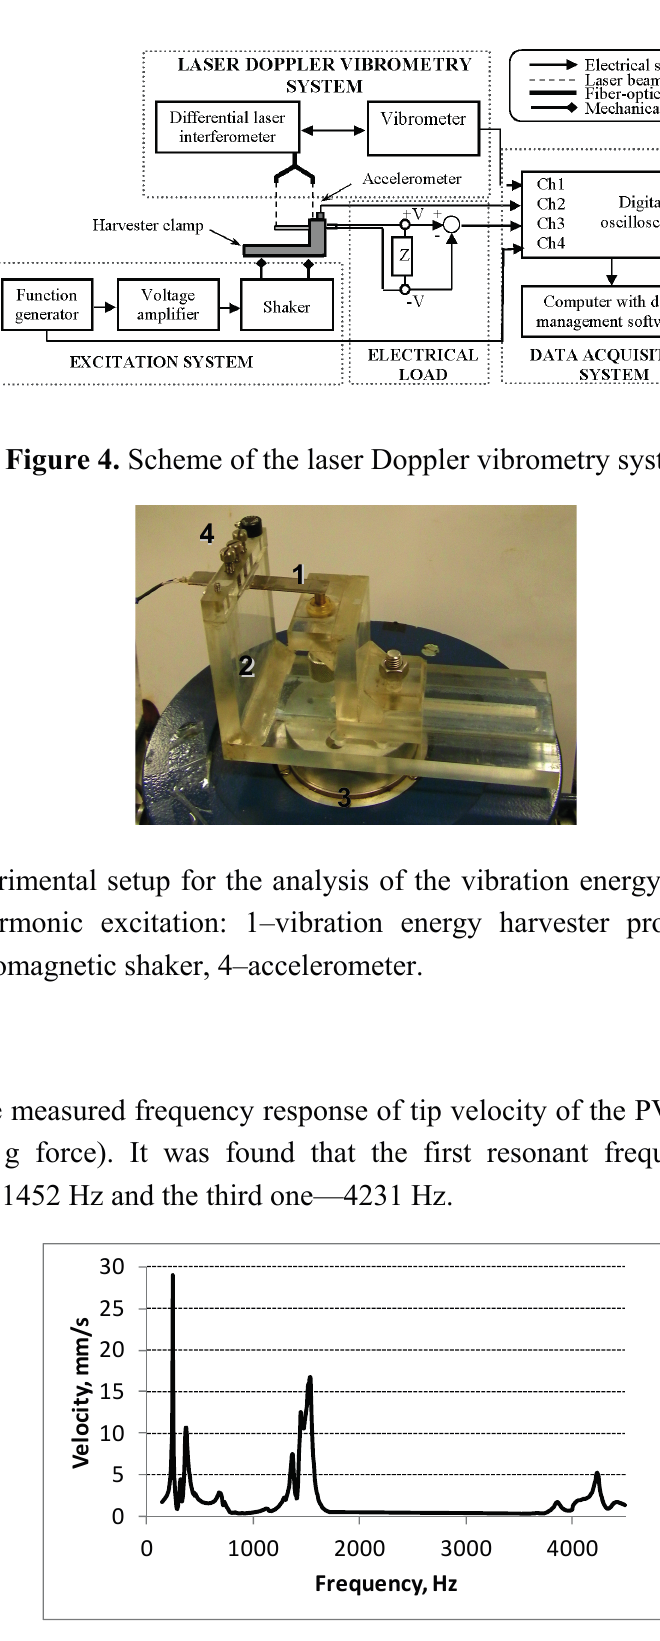
Figure 6. Measured frequency response of tip velocity of the PVEH